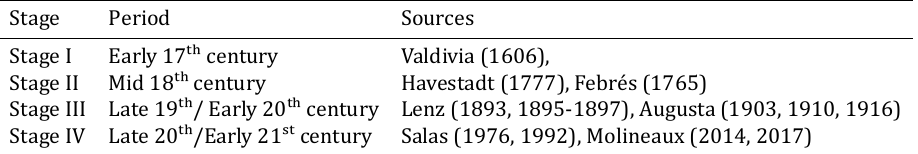
Table 6: Documented synchronic stages for